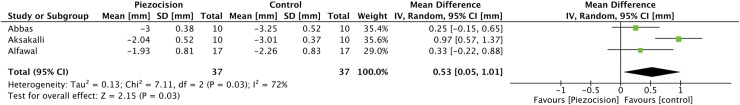
Forest plot showing anchorage loss differences between piezocision and control groups in canine retraction.